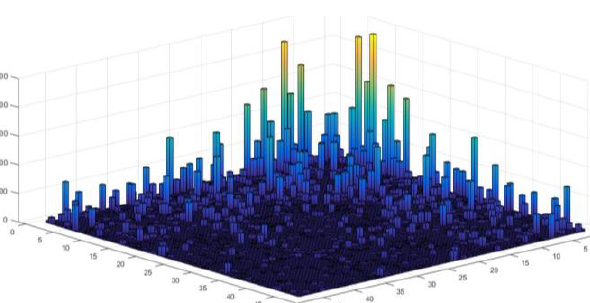
Figure 5. histogram of points lying on two corresponding planes in 85 planes’ algorithm.